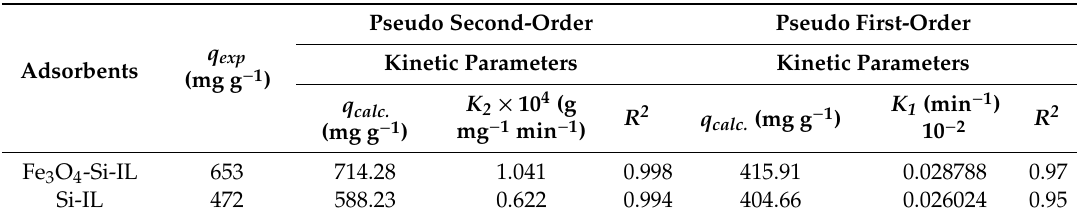
Table 2. Kinetic parameters of Fe 3 O 4 -Si-IL and Si-IL composites for removal of CR from aqueous solution at 298 K.